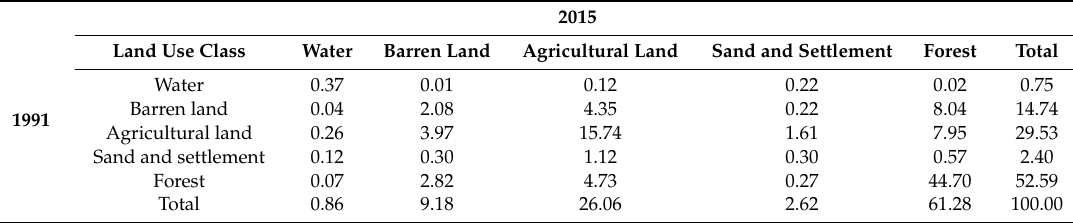
Table 4. Land use land cover change dynamics from 1991–2015 (in